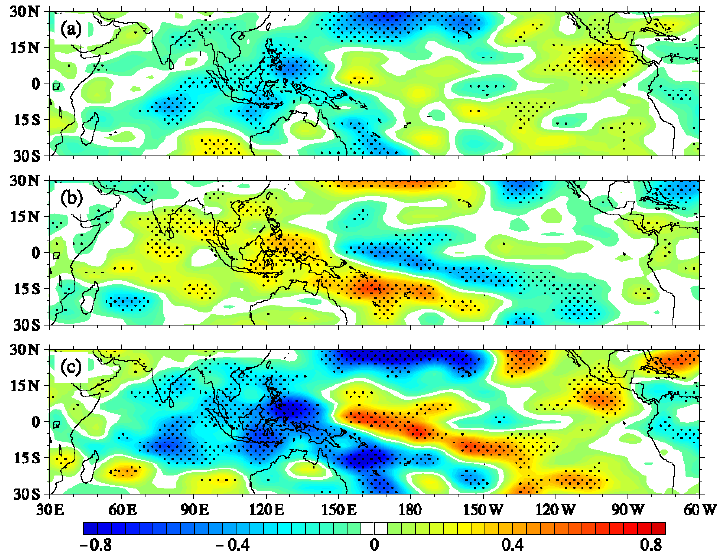
Figure 2. Composite anomalous MJO zonal wind amplitude at 850 hPa (m·s −1 ) during the ( a ) positive and ( b ) negative phases of the PIOAM, and ( c ) their difference (positive minus negative). Results passing the significant test at the 90% confidence level are stippled.